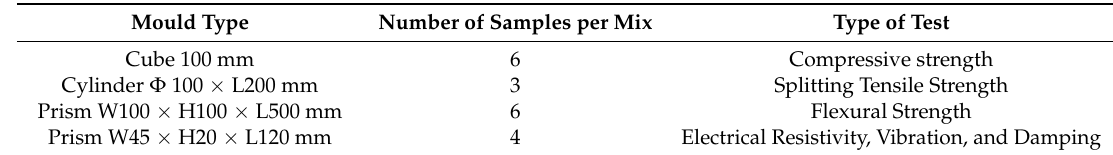
Figure 6. Specimen shapes ( left ); curing tank ( right ). Table 4. Types of moulds and corresponding tests.